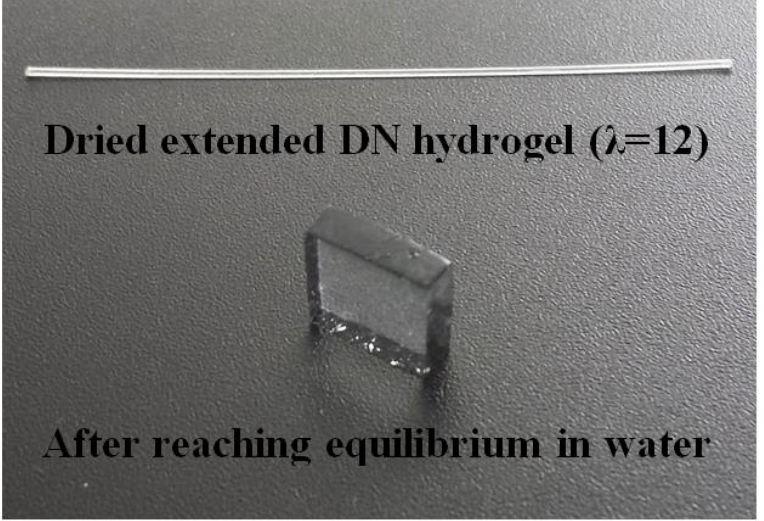
Figure 6. AMPS(1,2,2,9)/AAm(2,0.1,0.01,97) DN hydrogel; top: a segment of dried gel stretched up to λ = 12; bottom: the top dried gel rehydrated to the equilibrium swelling ratio. The time to onset of stress release (TOSR) was defined as the time it took for a stretched, dried DN hydrogel to begin bending when the hydrogel was immersed in water. Figure 7 compares the TOSR for the AMPS(1,2,2,9)/AAm(2,0.1,0.01,97) DN hy- drogels with different stretch ratios. The TOSR decreased with increasing stretch ratio.